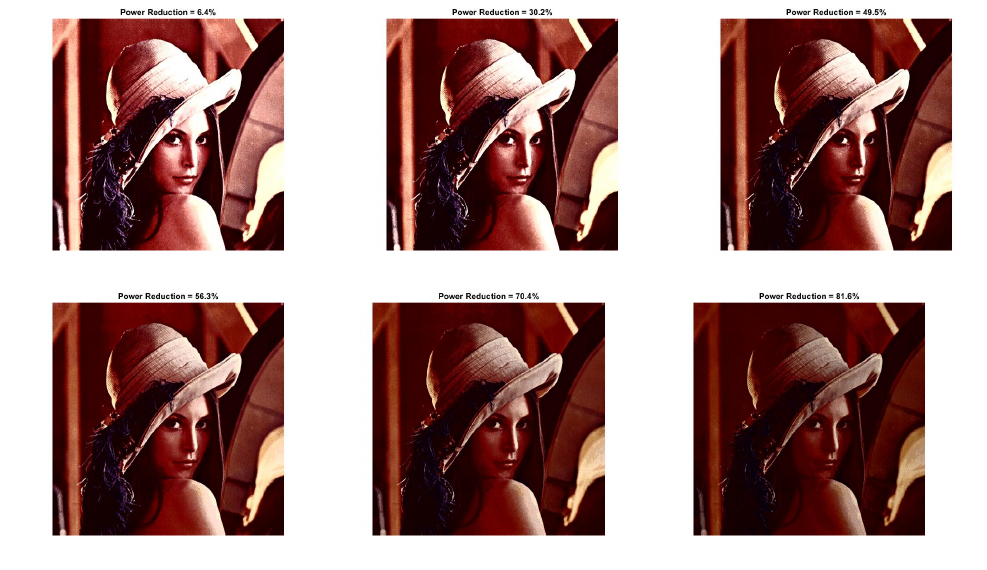
Figure 7. Lena resulted image I new for a = { 0.5,0.7 } , b = [80:10:100].